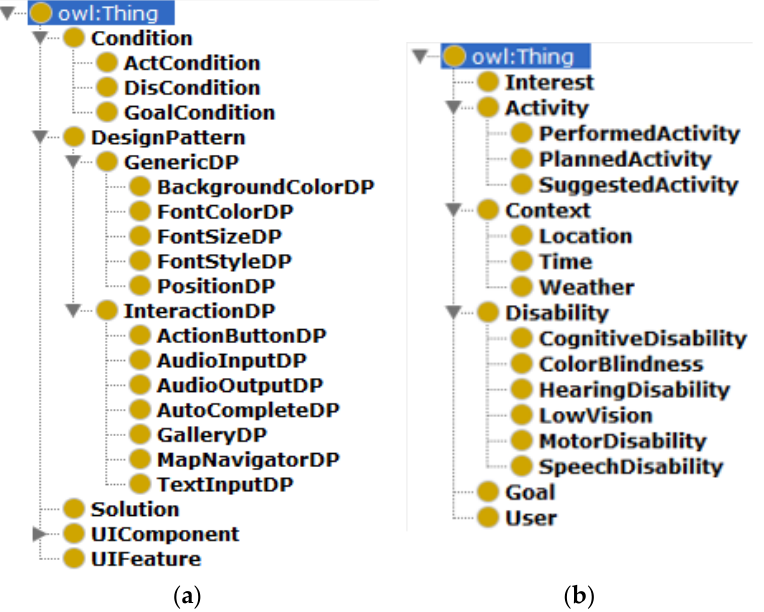
Figure 6. Ontological models representing the UI design pattern and the user profile. ( a ) UI design pattern, ( b ) user